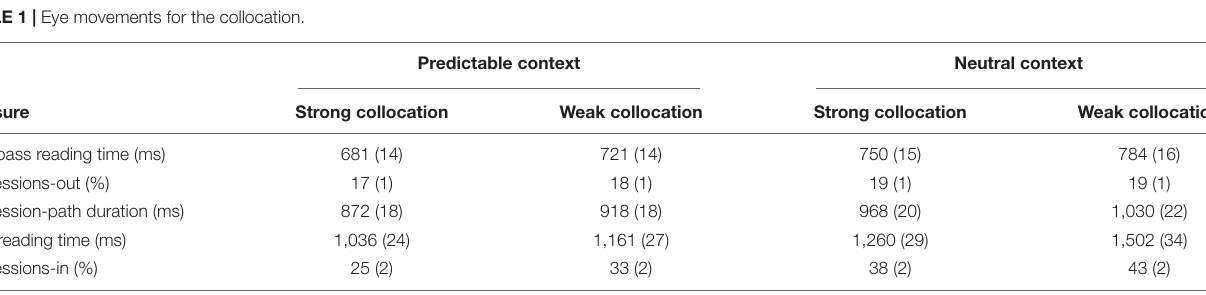
FIGURE 1 | An example stimulus. Collocations are shown underlined with the alternative strong and weak collocations separated using a slash. These stimuli were shown as normal in the experiment, including either strong or weak collocation. TABLE 1 | Eye movements for the collocation.